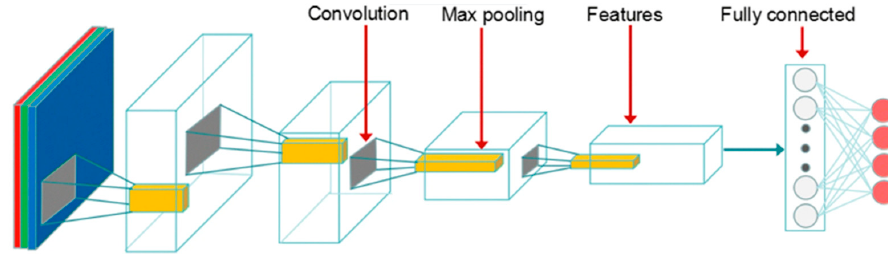
Figure 1. The ResNet50 blocks [27].